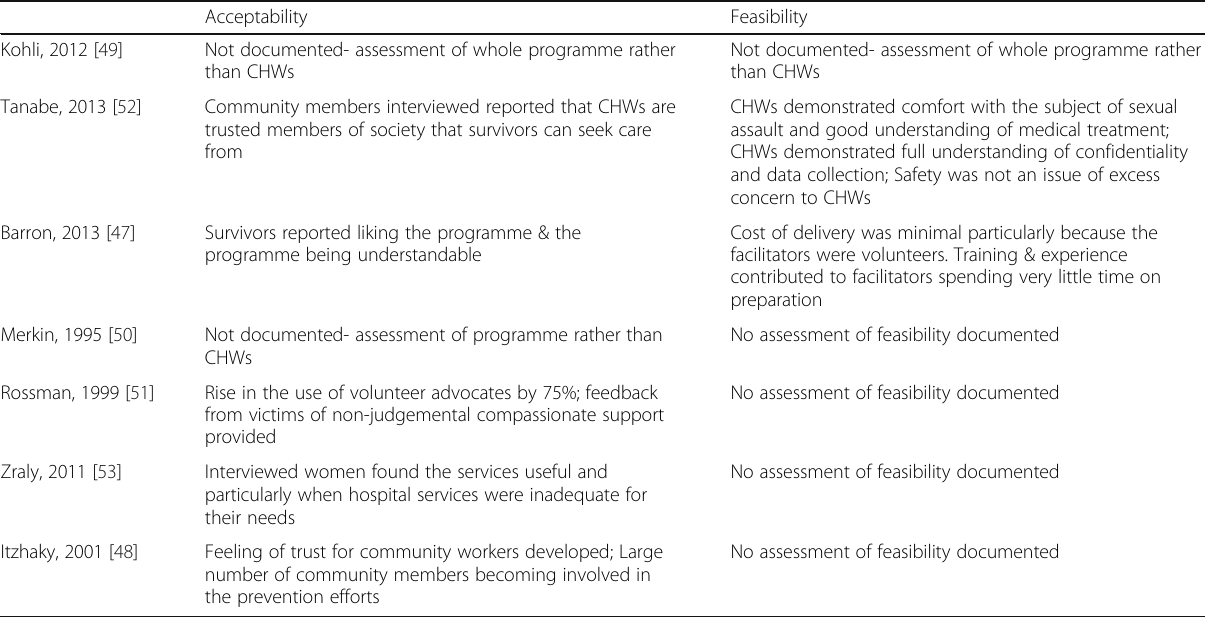
Table 6 Reported acceptability and feasibility of CHWs in sexual violence